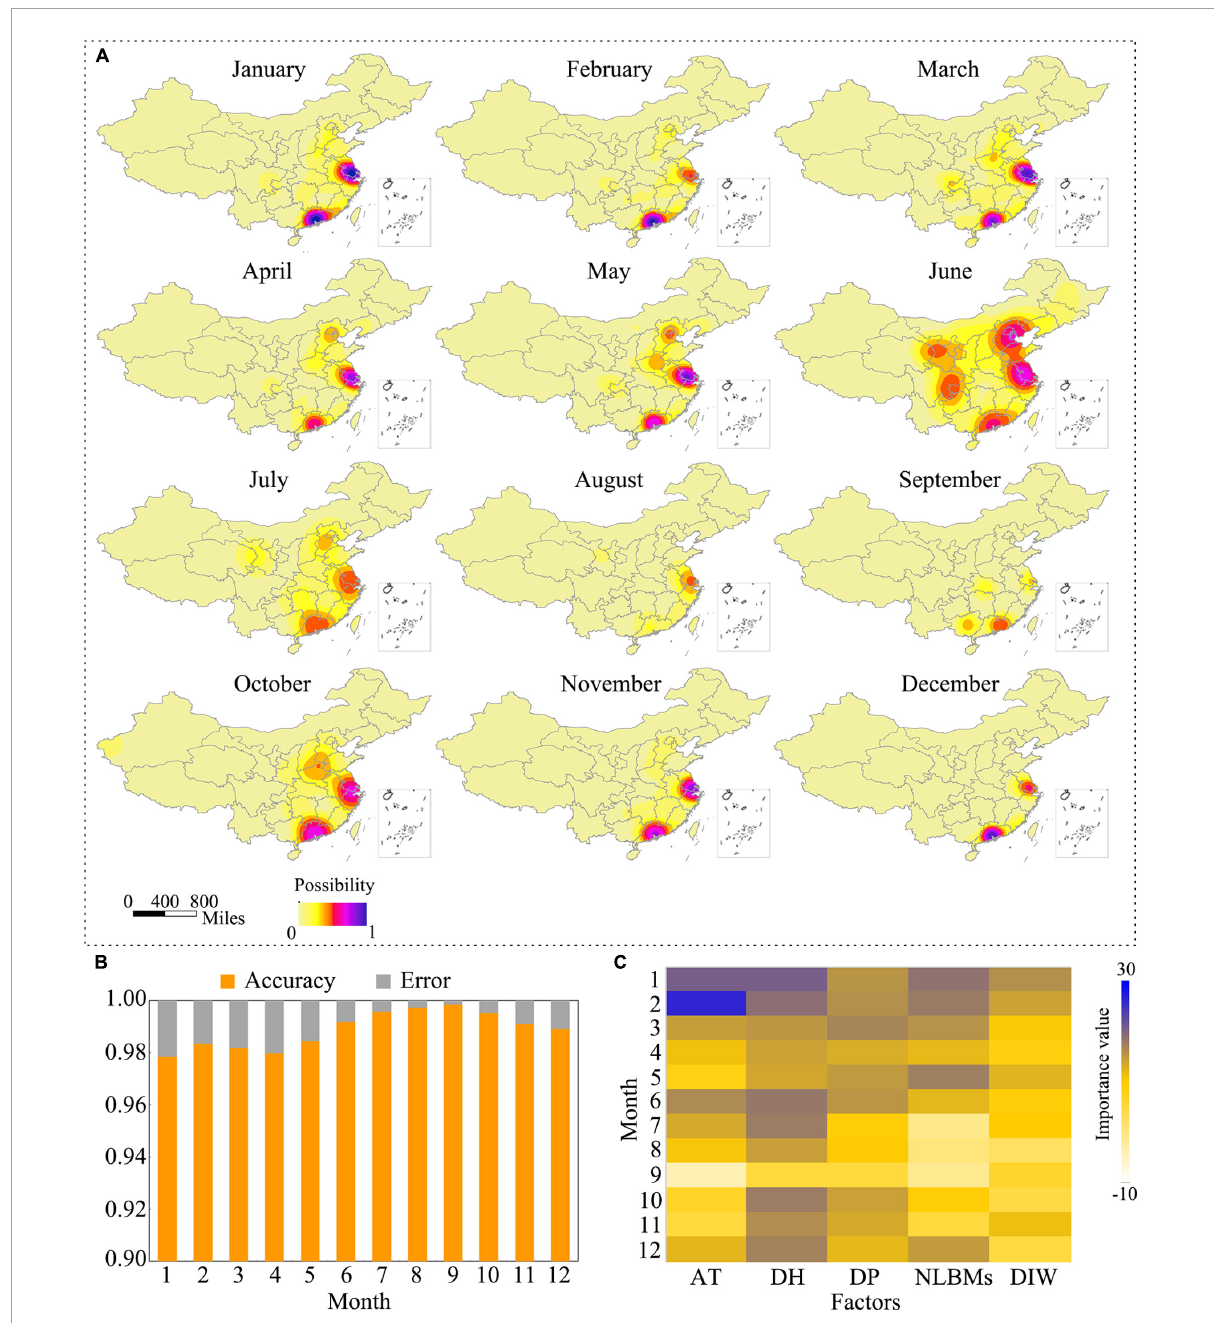
FIGURE7 Occurrence risk of H7N9 in mainland, China. (A) Monthly occurrence risk of H7N9 in mainland, China. The occurrence risk was predicted using the random forest algorithm implemented in R. The risk maps were generated using QGIS 3.4. (B) Accuracy of the predictions. (C) Importance of the risk factors. “AT” represents the monthly average temperature; “DH” represents the density of human population; “DP” represents the density of poultry population; “NLBMs” represents the number of live bird markets; “DIW” represents the density index of water